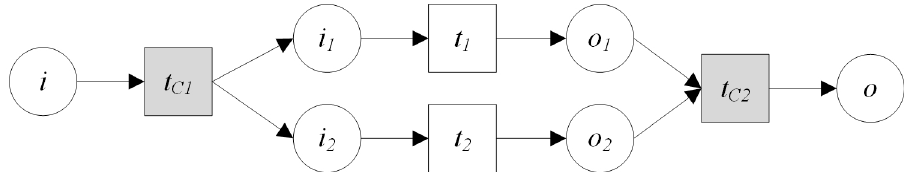
Figure 10. Parallel